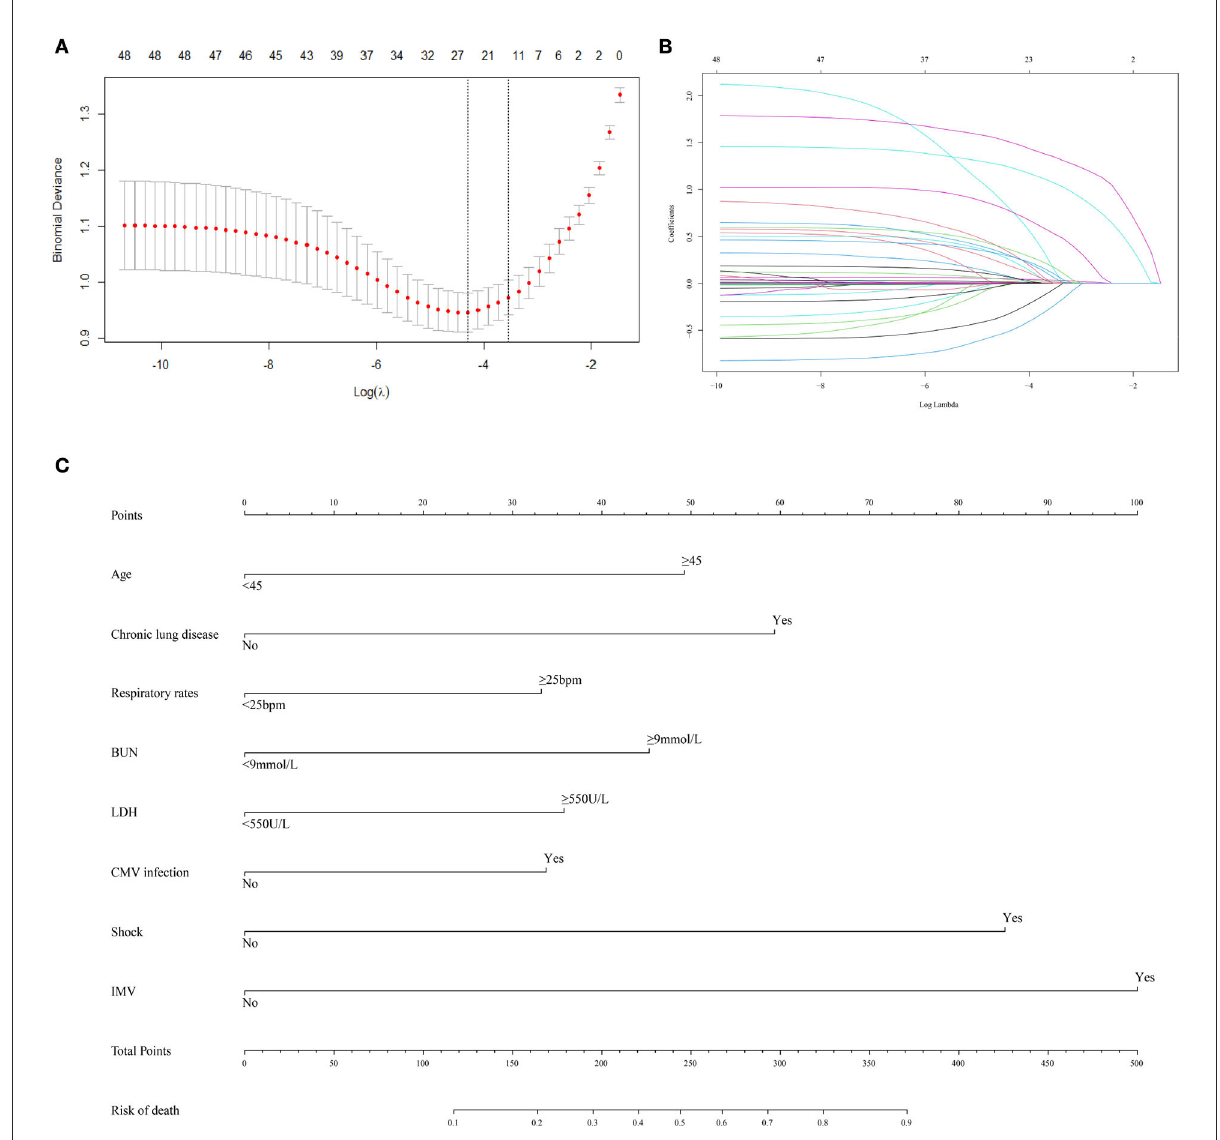
FIGURE1 Predictor selection and prognostic nomogram development for predicting death risk of patients with PCP. (A) Identification of optimal parameters (lambda) in the LASSO model using minimum criteria and 5-fold cross-validation. Dotted vertical lines are drawn at the selected values using the minimum criteria and the 1 standard error of the minimum criteria (1-SE criteria); (B) LASSO coefficient profiles of 48 features; (C) predictor scores were found on the uppermost point scale that matched with the value of each variable. The sum of these scores is located on the total points axis, and a line is drawn straight down to get the percent probability of death. LASSO, least absolute shrinkage and selection operator; bpm, beat per minute; BUN, blood urea nitrogen; LDH, lactate dehydrogenase; CMV, cytomegalovirus; IMV, invasive mechanical